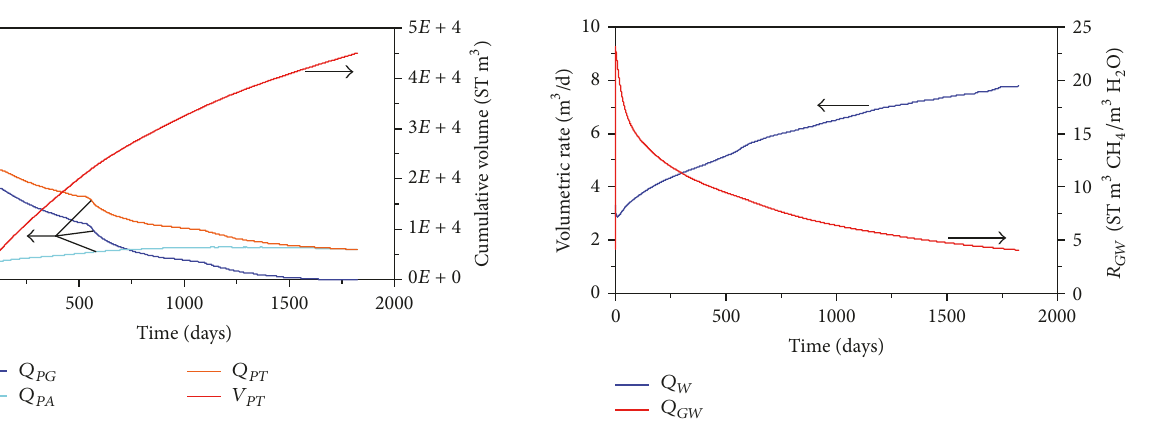
Figure 7: Evaluation of water volumetric production rate ( 𝑄 𝑊 ) and the gas-to-water ratio ( 𝑅 𝐺𝑊 ) during gas production from horizontal